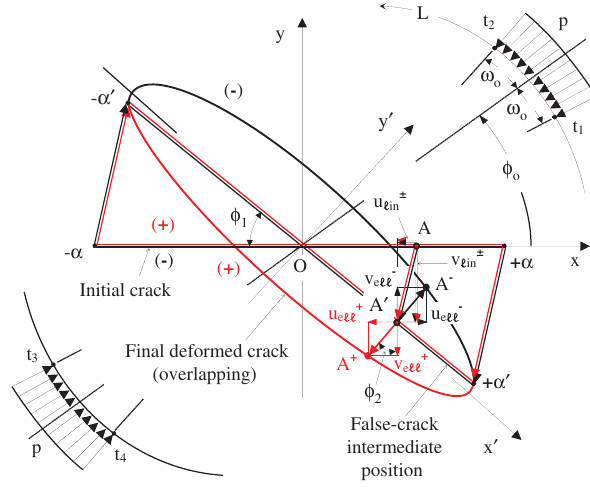
Figure 3 Schematic representation of the overlapping phenomenon of the crack lips (out of